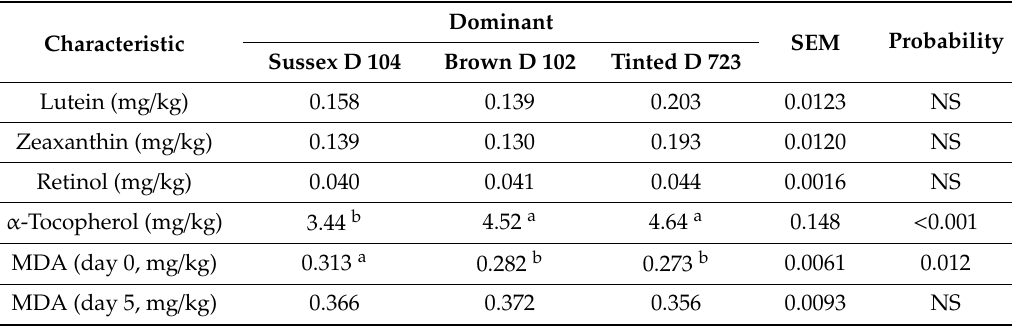
Table 5. Carotenoid and vitamin contents and oxidative stability of fat in breast meat.